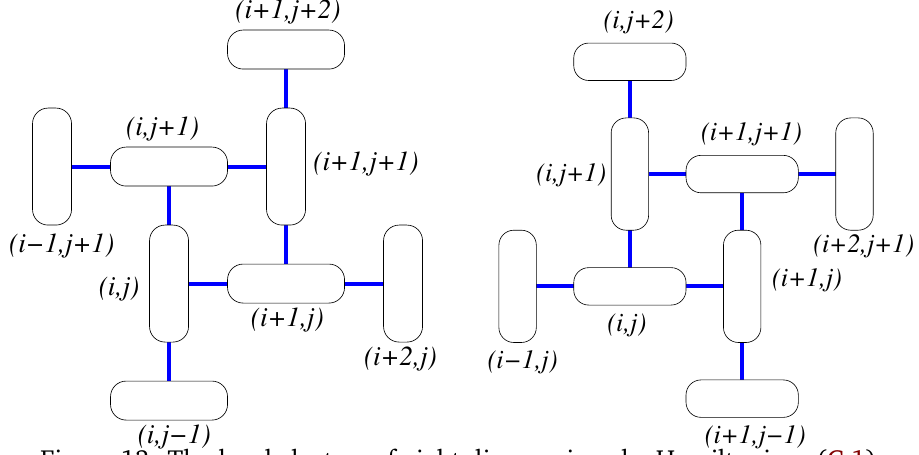
Figure 13: The local clusters of eight dimers given by Hamiltonians (C.1).